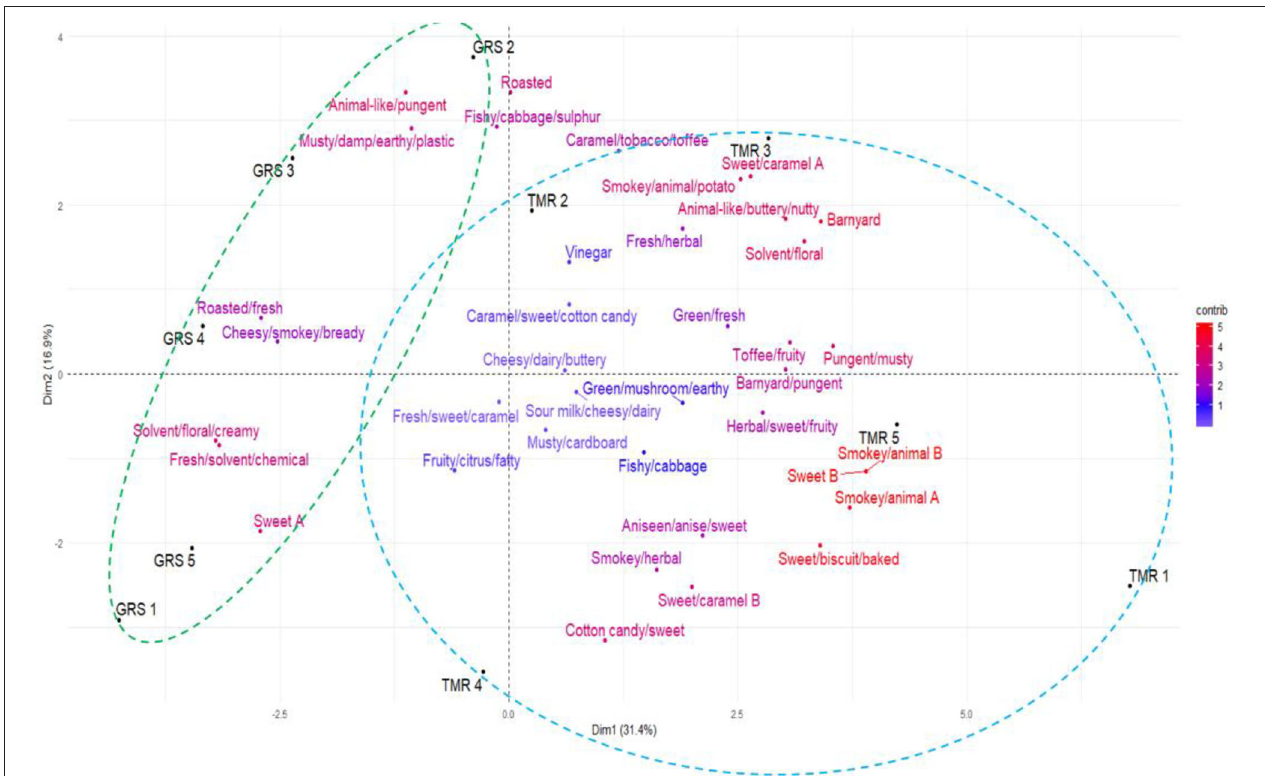
FIGURE 1 | Principal component Biplot analysis of the odour descriptors perceived by the five panellists based on odour intensity values for raw GRS and total mixed ration (TMR) milk. Colour gradient: low = white, mid = blue, high = red, midpoint set at